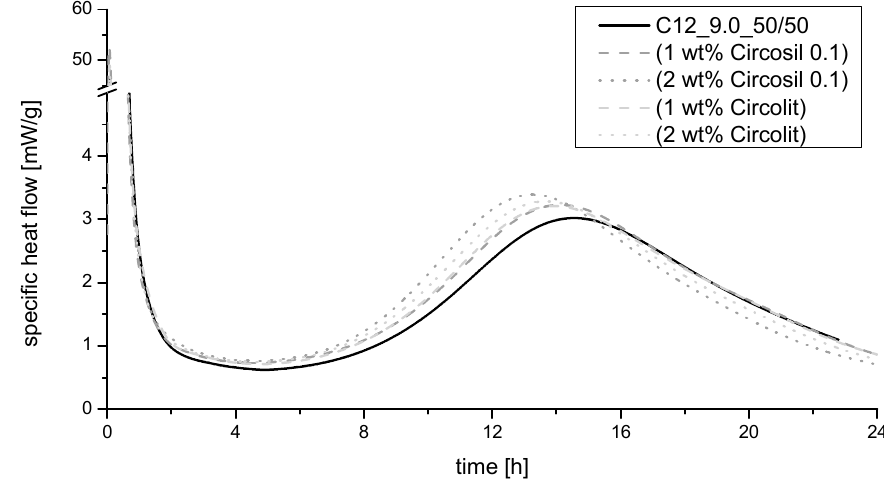
Figure 4. Specific heat flow measured for 24 h in dependency of C ‐ S ‐ H ‐ seeds addition.